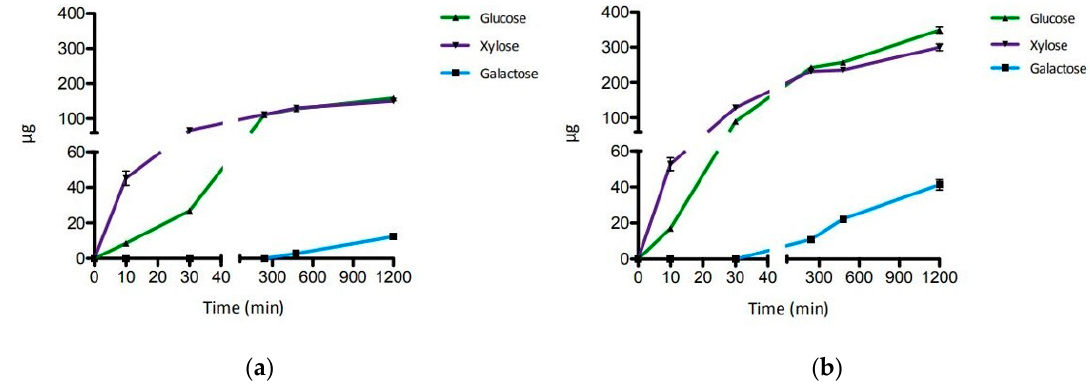
Figure 2. Time course of the enzymatic hydrolysis of XGO1. ( a ) LacS 2.2 U and XylS 0.1 U. ( b ) LacS 18 U and XylS 0.1 U. Error bars reported represent standard deviations.